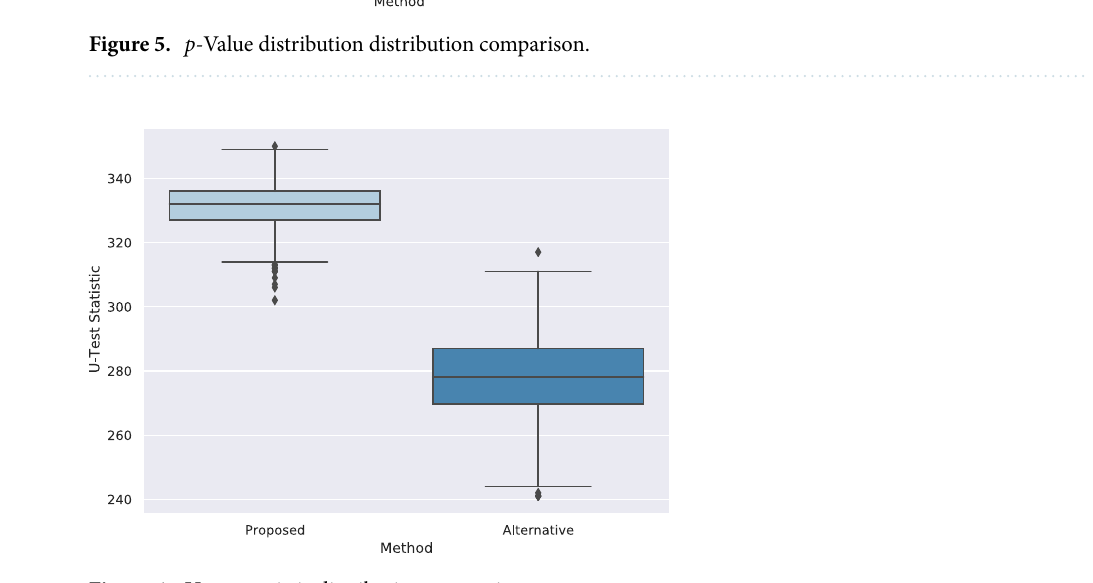
Figure 6. U-test statistic distribution comparison.